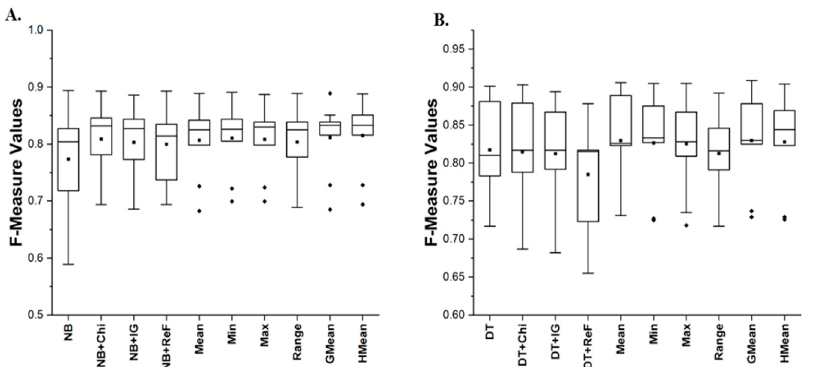
Figure 3. Box-plot representations (AUC values) of NB and DT classifiers with FS methods. ( A ) Average AUC values of NB; ( B ) Average AUC values of DT.